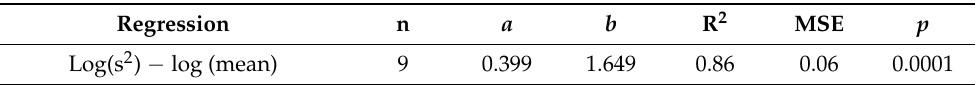
Table 3. Parameters of the linear regressions between the sample variance (log(s 2 )) and the mean abundance of benthic macroinvertebrates